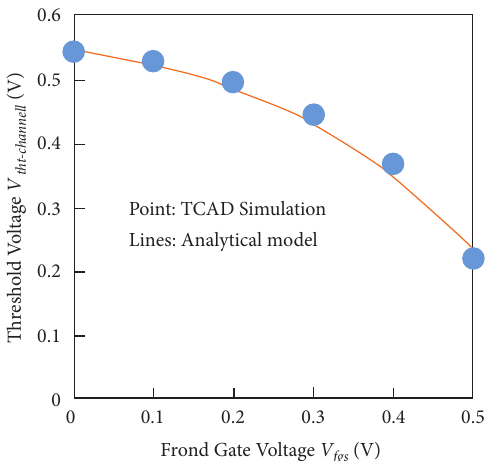
Figure 4: The analytical model and TCAD simulation results of the threshold voltage of the top gate for Subchannel 1.